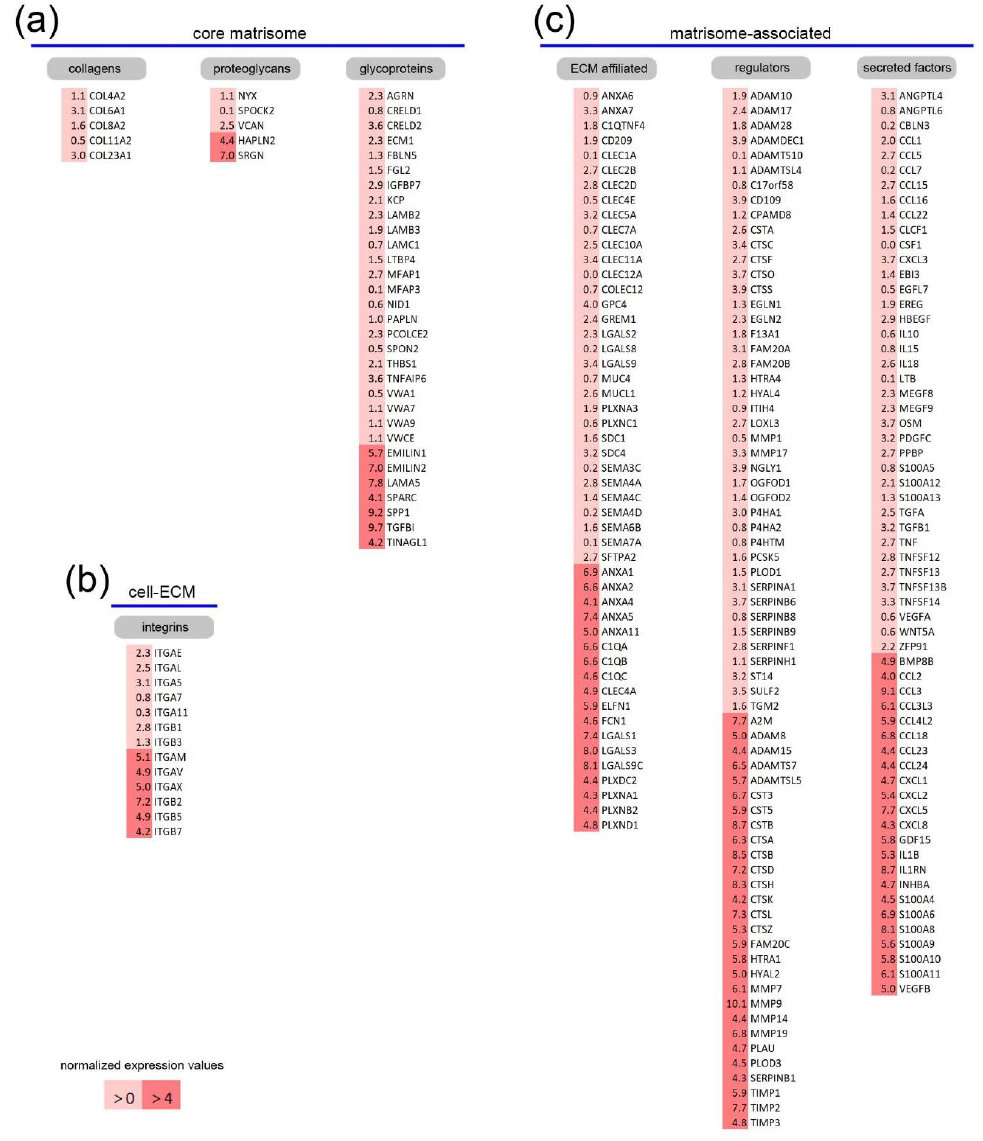
Figure 2. Identification of highly expressed core matrisome and matrisome-associated genes in primary human macrophages. The most highly expressed genes of the core matrisome ( a ), cell–matrix interaction-mediating integrin ( b ) and matrisome-associated genes ( c ) are listed according to intermediate (light red) and high (red) expression. Normalized expression values are given and the complete set of genes with respective expression values is given in the Table S1. Among genes encoding members of the collagen family only the network-forming COL4A2 , COL6A1 and COL8A2 , the fibril-forming COL11A2 and the membrane-bound COL23A1 were moderately expressed (Figure 2a). Other chains and collagen genes were expressed at lower levels (Table S1). Five proteoglycan-related genes were expressed at higher levels and serglycin ( SRGN ) and hyaluronan and proteoglycan link protein 2 ( HAPLN2 ) were most strongly expressed in MDMs. Notably, two other hyaluronan and proteoglycan link proteins (HAPLN3 and HAPLN4) were expressed in MDMs at lower levels (Table S1). Link proteins are known to stabilize the interaction of hyluronan and lecticans and, interestingly, the lectican versican ( VCAN ) was moderately expressed